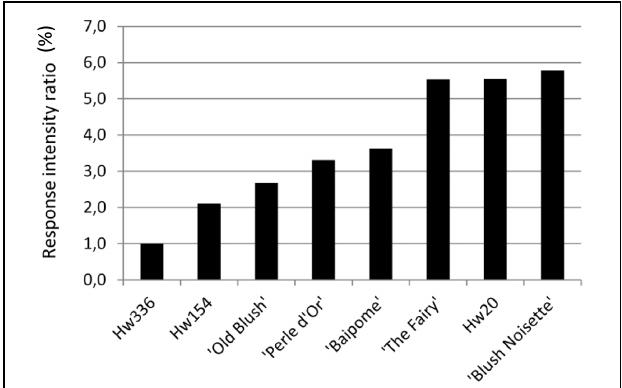
FIGURE 4 | Intensity of the architectural response per